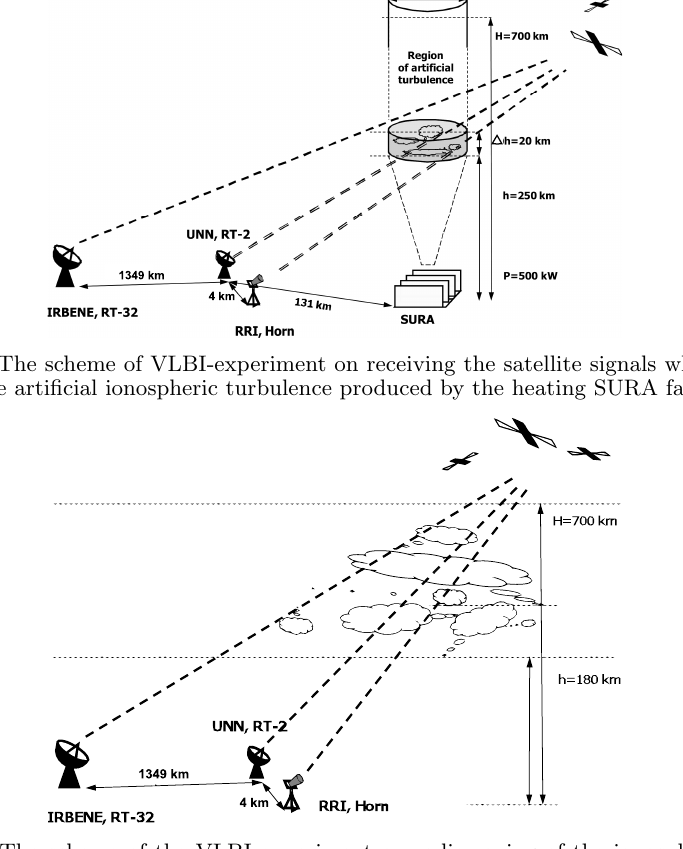
Fig. 2. The scheme of the VLBI experiment on radio raying of the ionosphere by a signal of space